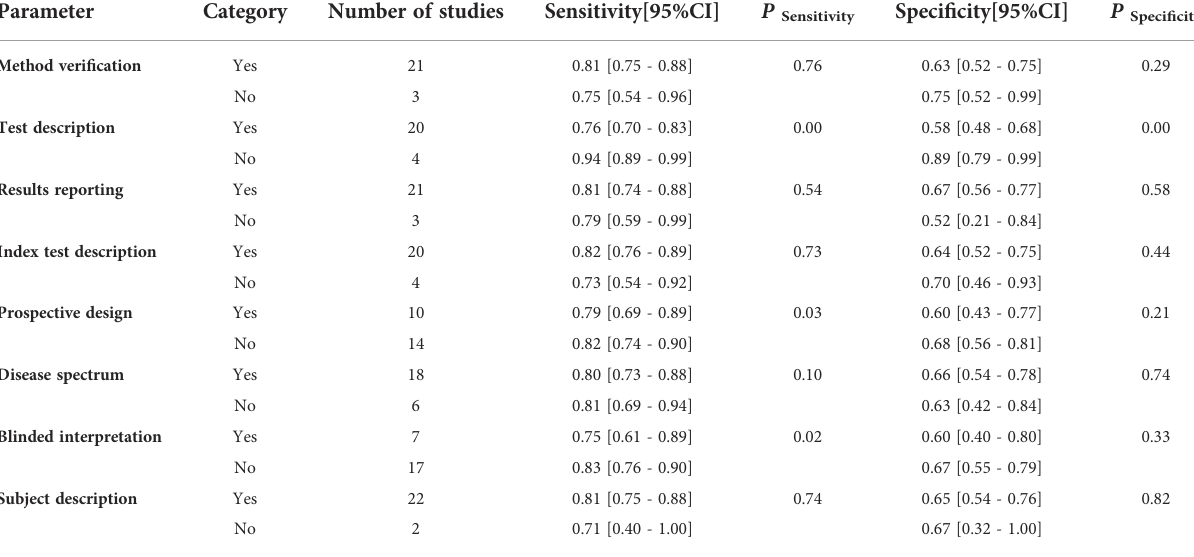
TABLE 2 The result of uni-variable Meta-regression of subgroup analysis.